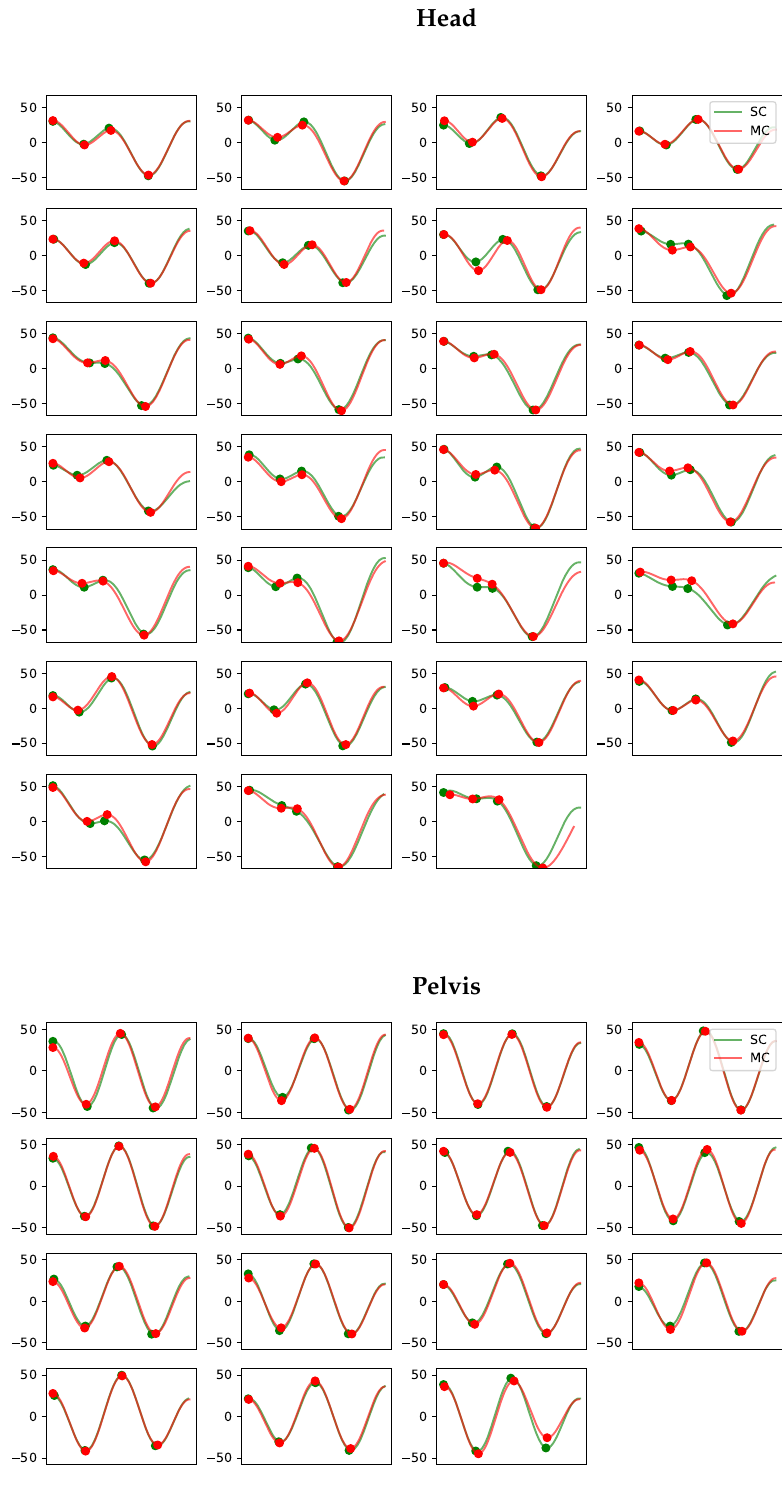
Figure A10. Vertical displacement signals per stride for the head and pelvis for horse 11. Each subplot contains the matched stride segments for the single-camera markerless system (SC) in green and the multi-camera marker-based system (MC) in red. The y-axis shows the vertical displacement in millimeters. The four dots on each curve indicate the positions of the two peaks and two valleys extracted using the approach in Section